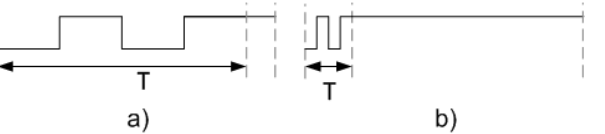
Figure 9. Representation of the short pulse definition using the variable T. ( a ) Short pulse with a high period and ( b ) short pulse with a small